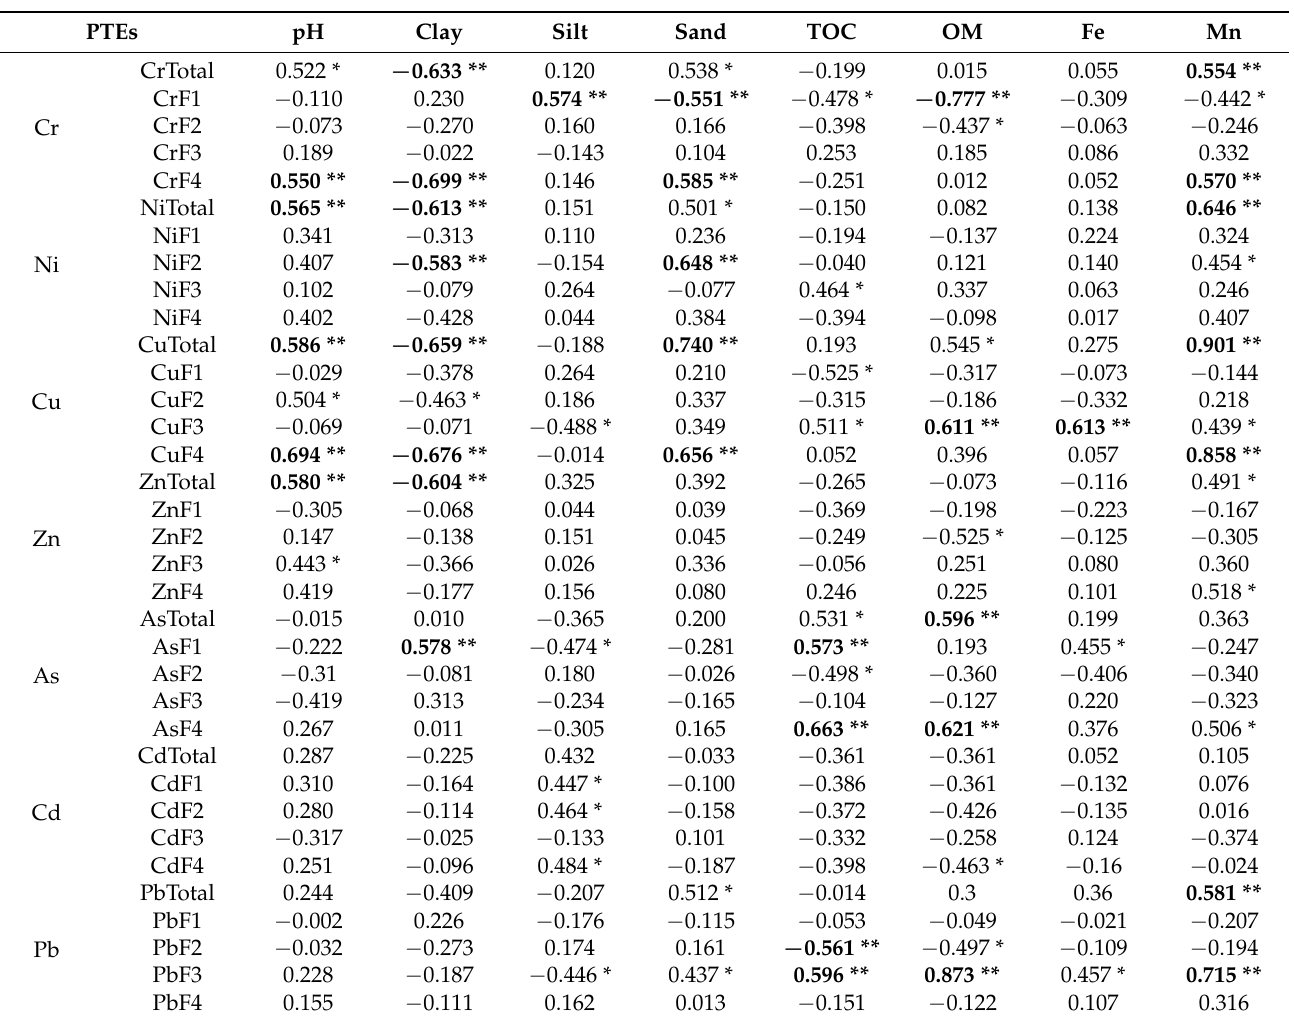
Table 1. Pearson correlation analysis among sediments physicochemical properties and total contents, chemical fractions of